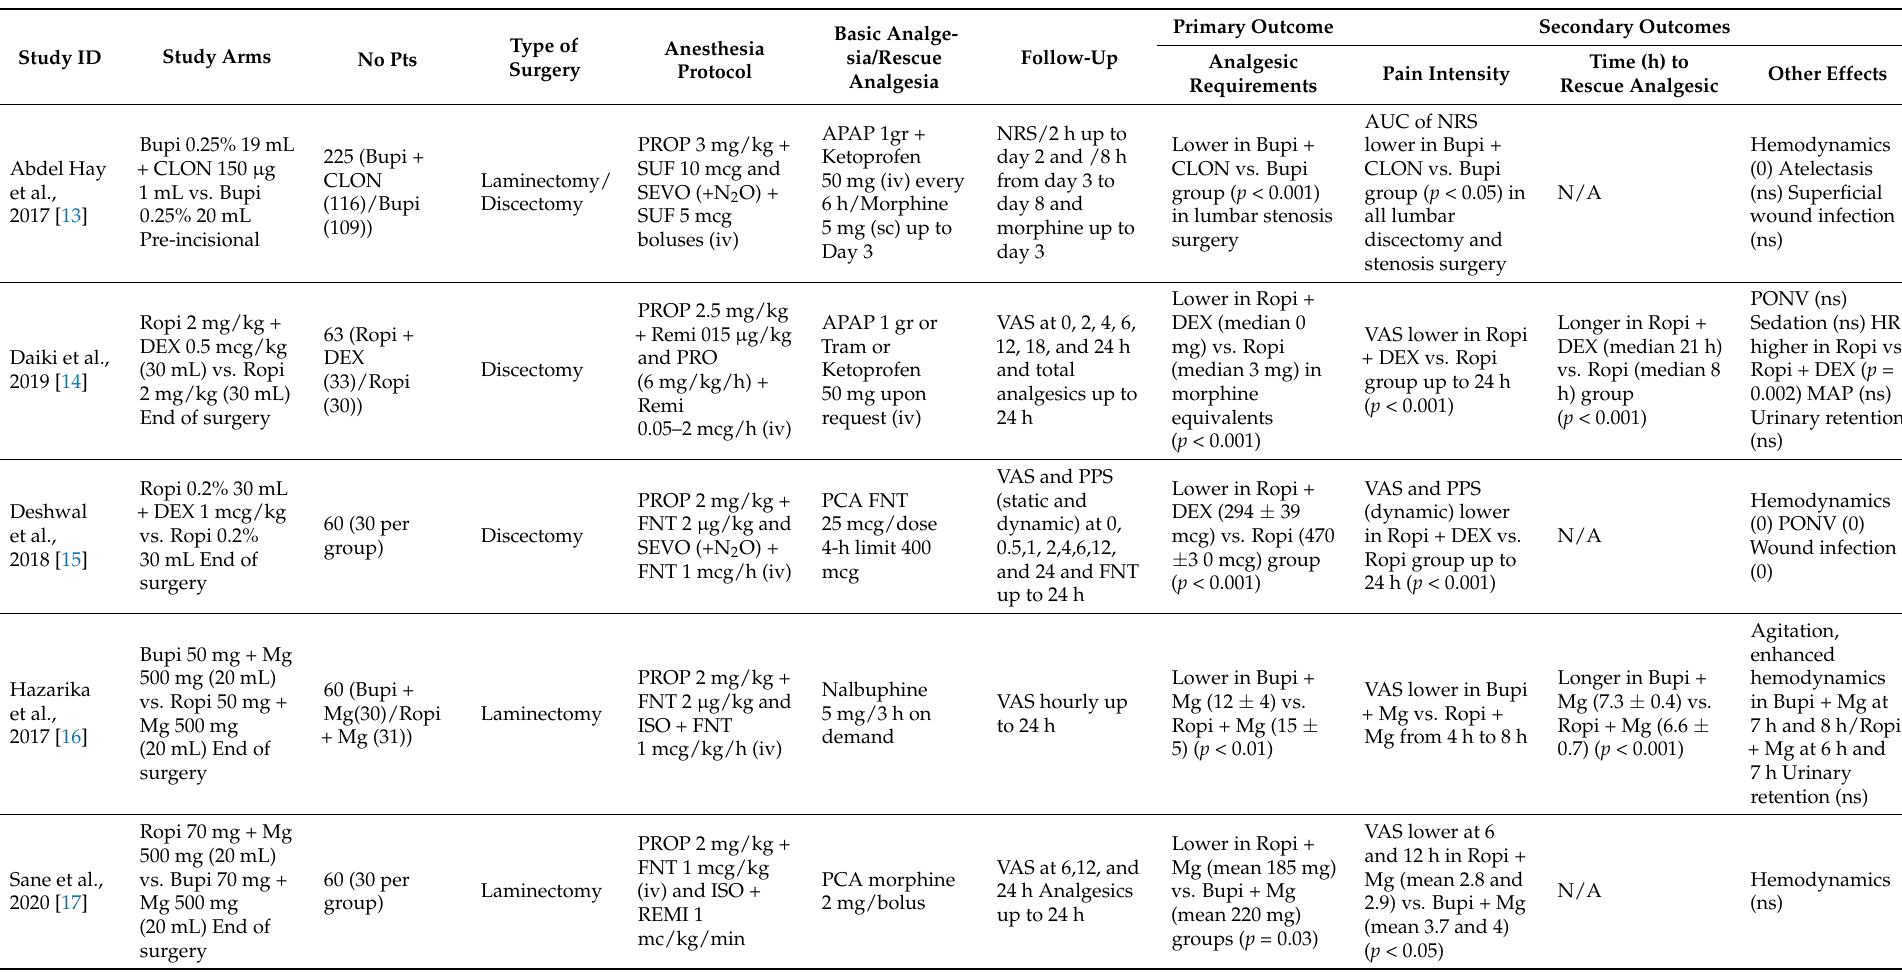
Table 3. Characteristics of the included studies involving local wound infiltration for pain control after lumbar spine